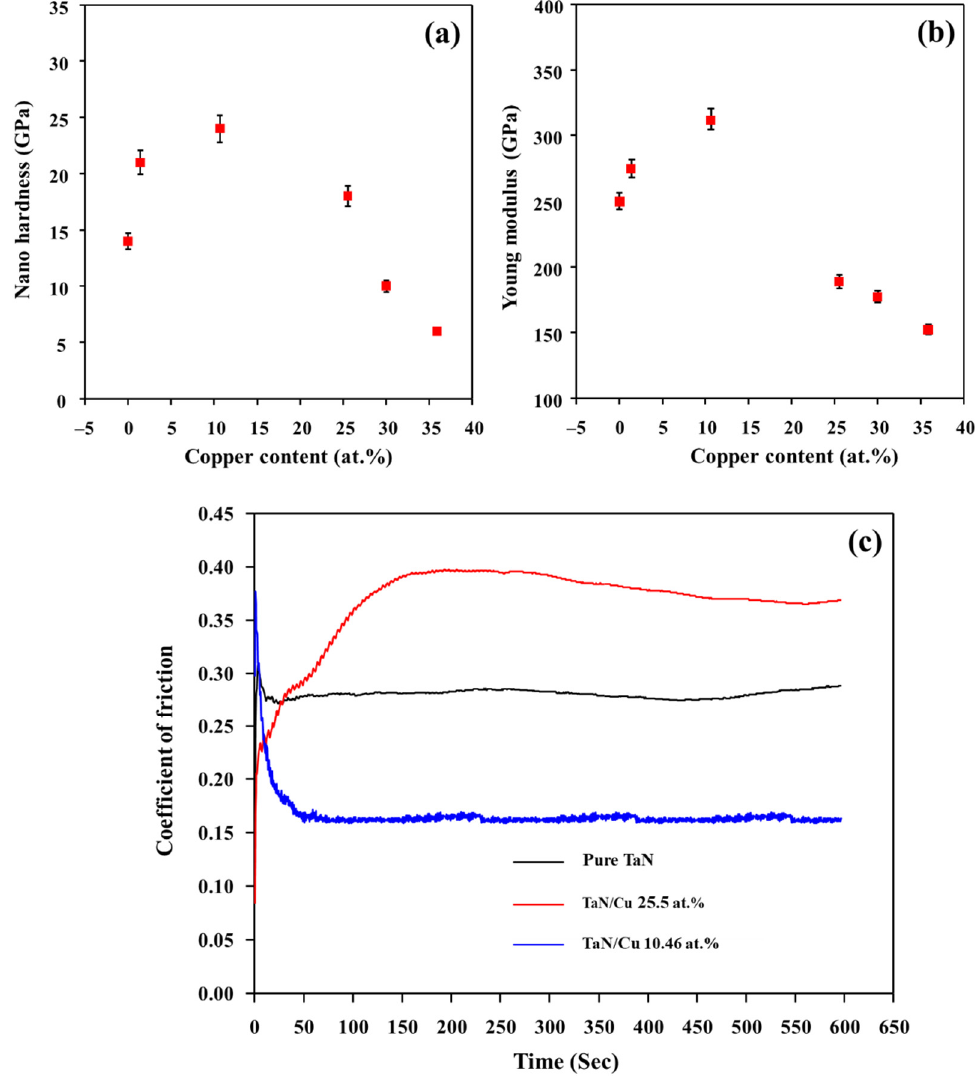
Figure 6. ( a ) Hardness, ( b ) young modulus of TaN/Cu nanocomposite coatings with respect to copper content (at.%), and ( c ) friction coefficient of coatings with respect to time (sliding distance).